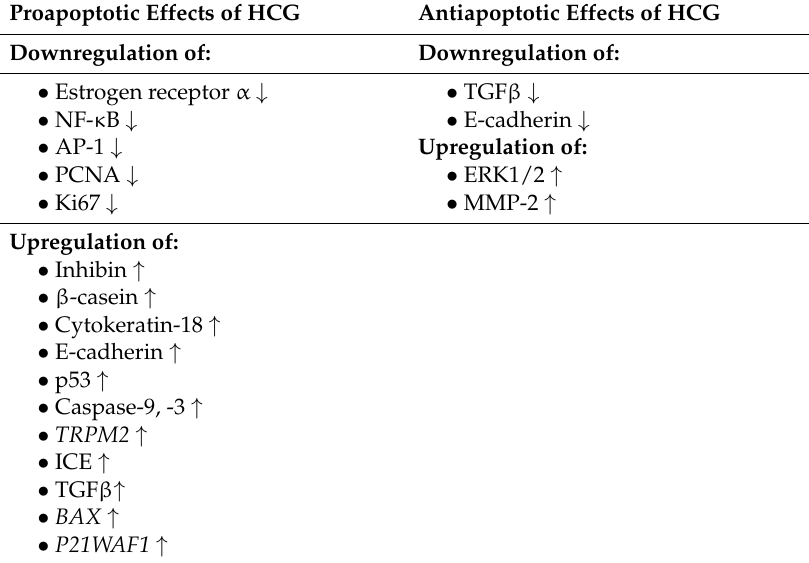
Table 1. Pro- and antiapoptotic effects of human chorionic gonadotropin (HCG). Proapoptotic Effects of HCG Antiapoptotic Effects of HCG Downregulation